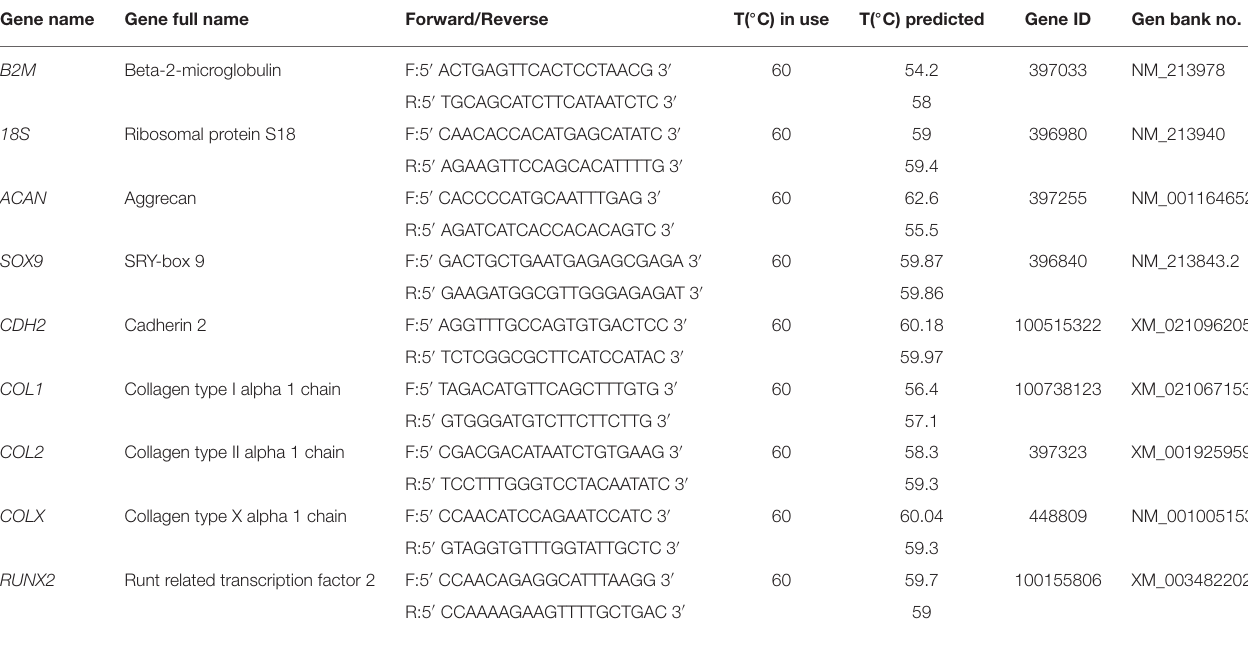
TABLE 2 | List of specific primers for real time